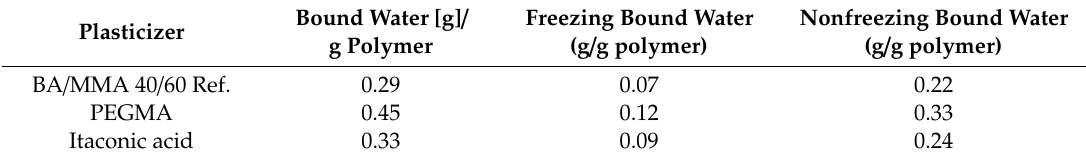
Table 4. Amount of bound water (g / g polymer), separated in freezing and nonfreezing water calculated from DSC, by measurement after the immersion of the polymer in water for one week. Bound Water [g] / Plasticizer g Polymer (g / g polymer) (g / g polymer) BA / MMA 40 / 60 Ref.